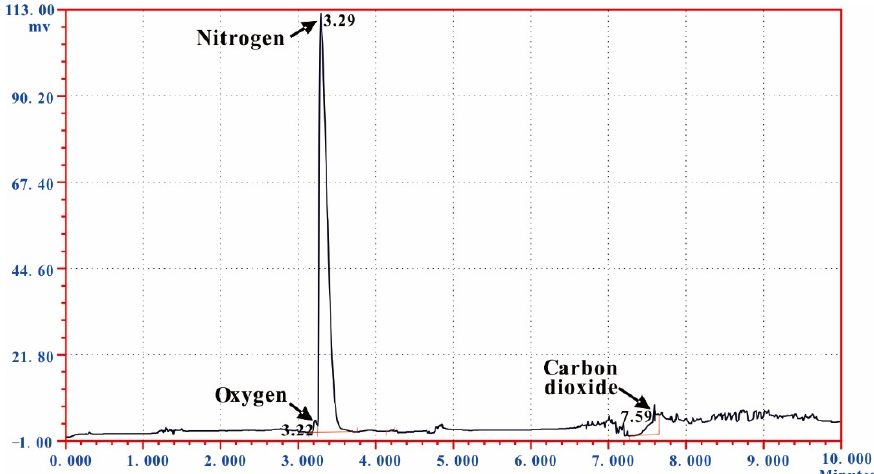
Figure 11. Analysis results of gas components collected after the reaction.